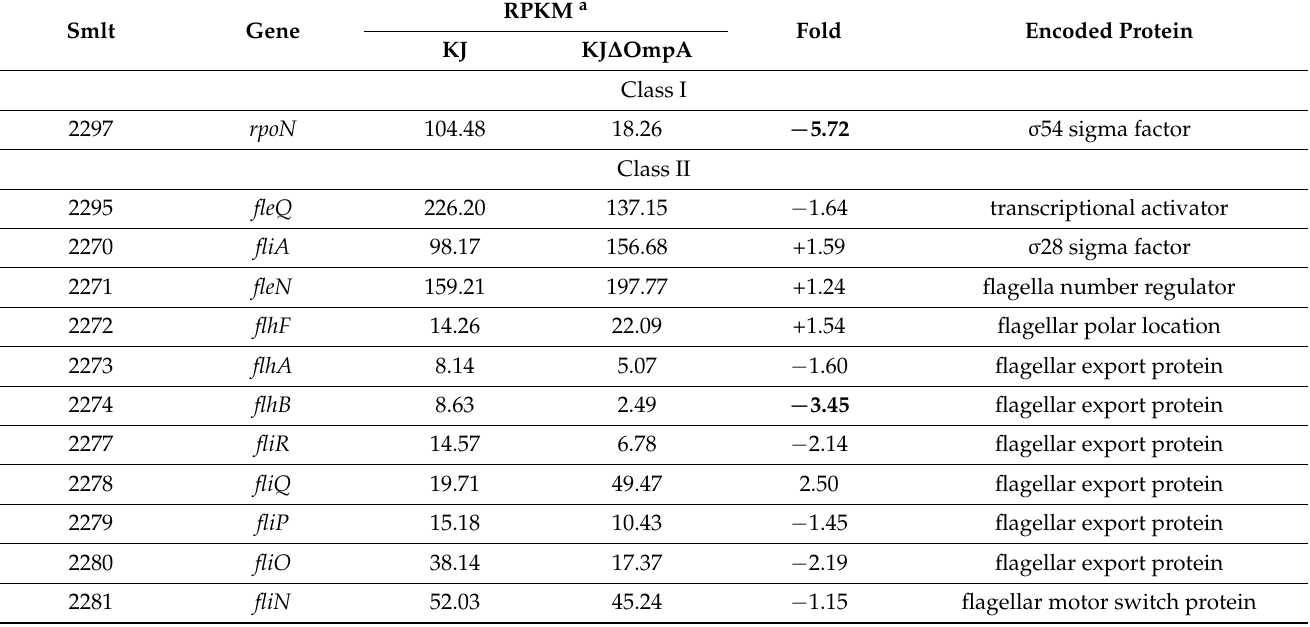
Figure 5. Impact of ompA on the expression of flagellum-associated genes. Overnighted cultured bacterial cells (KJ, KJ Δ OmpA, and KJL2:OmpA Δ OmpA) were inoculated into fresh LB broth and then grown for 5 h before a qRT-PCR. The expression levels of the assayed genes were normalized to those of the 16 S ribosomal RNA gene. The relative transcript was calculated using the wild-type KJ level as one. The mean and SD of the three independent experiments are shown. *, p < 0.05, significance calculated using the Student’s t -test. Table 1. Swimming-associated genes differently expressed in S. maltophilia KJ and KJ ∆